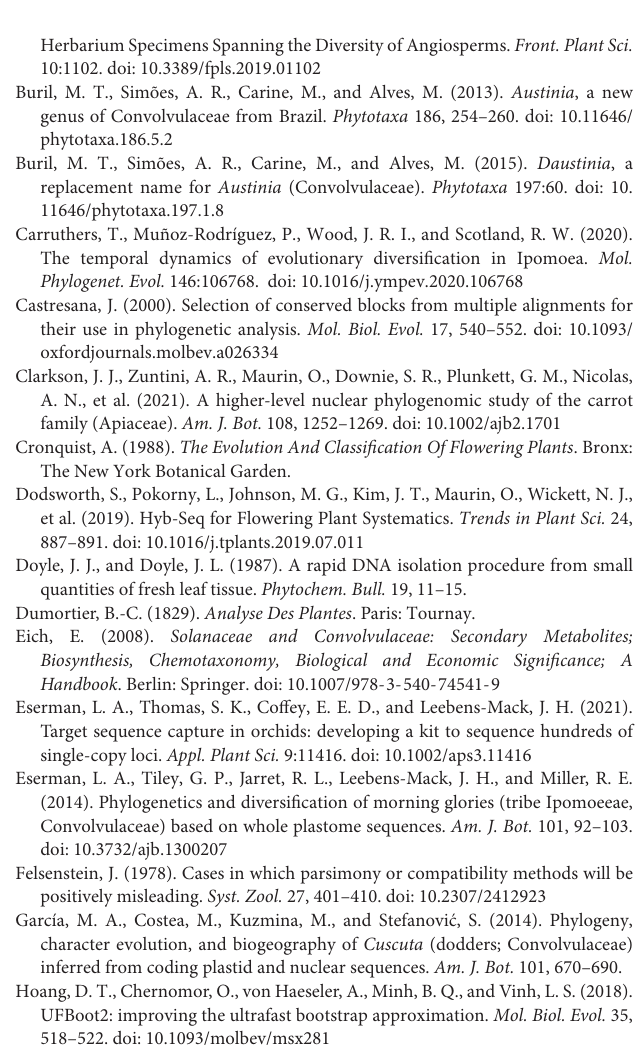
Supplementary Figure 2 | Phylogeny of Convolvulaceae with different dataset composition, exploring the impact of the inclusion of Cuscuta in the analyses. (A) without Cuscuta ; (B) with Cuscuta . Both trees were estimated using a concatenated dataset of 349 genes that were aligned in PRANK and cleaned in Gblocks. The concatenated dataset was analyzed in IQ-TREE2 with 1000 ultrafast bootstrap